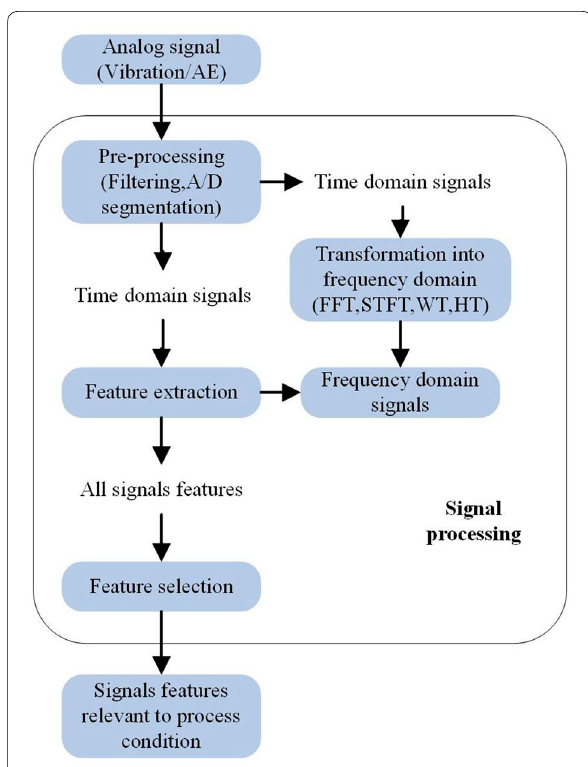
Figure 11 Signal extraction and selection process